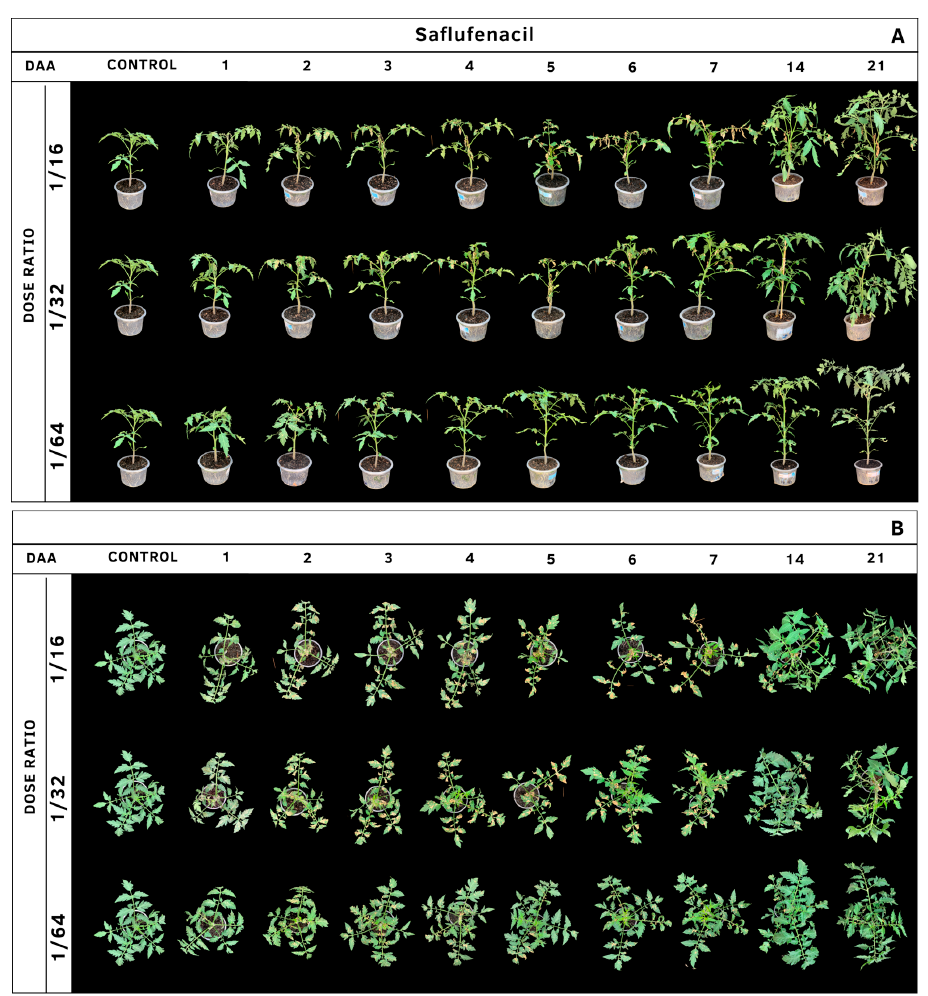
Figure 7. Symptoms evolution in tomato plants due to simulated saflufenacil drift at dose ratios 1/16D, 1/32D, and 1/64D (8.75, 4.38, and 2.19 g a.i. ha − 1 , respectively) of the recommended dose (D). Evaluations were made from 1 to 7, 14, and 21 days after application (DAA). Front view ( A ) and top view ( B ) of tomato plants affected by simulated